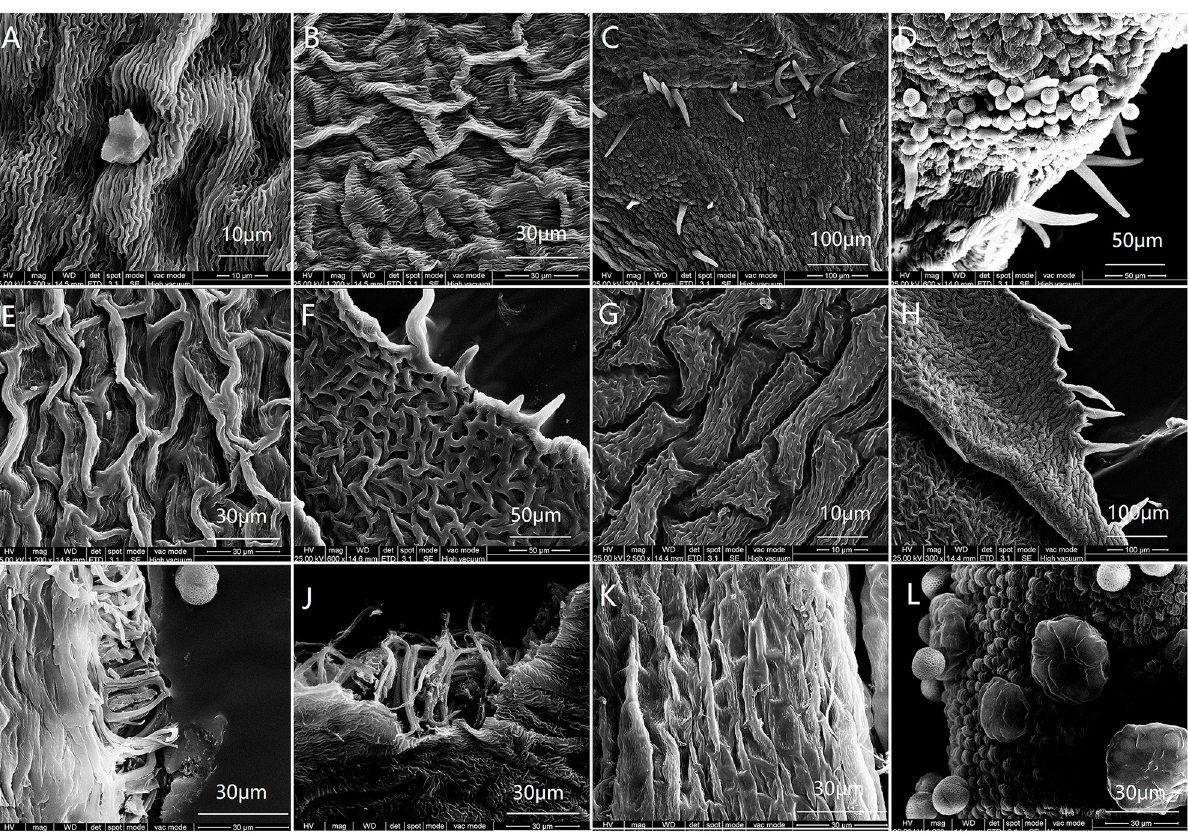
Fig 3. SEM micrographs of floral micromorphology in O . delavayi . Note: (A, C, E, F, I, K) Male. (B, D, G, H, J, L) Hermaphrodite. (A, B) Inner corolla. (C, D) Torus surface, trichomes present. (E-H) Calyx inner epidermal cells, margin pilose. (I, J) Inner anther, tapetum present. (K) Stigma of male, papillae present. (L) Ovary epidermal cells of hermaphrodite, papillae present. https://doi.org/10.1371/journal.pone.0221898.g003 Table 2. Measurements (Mean ± S. E.) of floral traits of males and hermaphrodites of O . delavayi from 6 populations. Sex